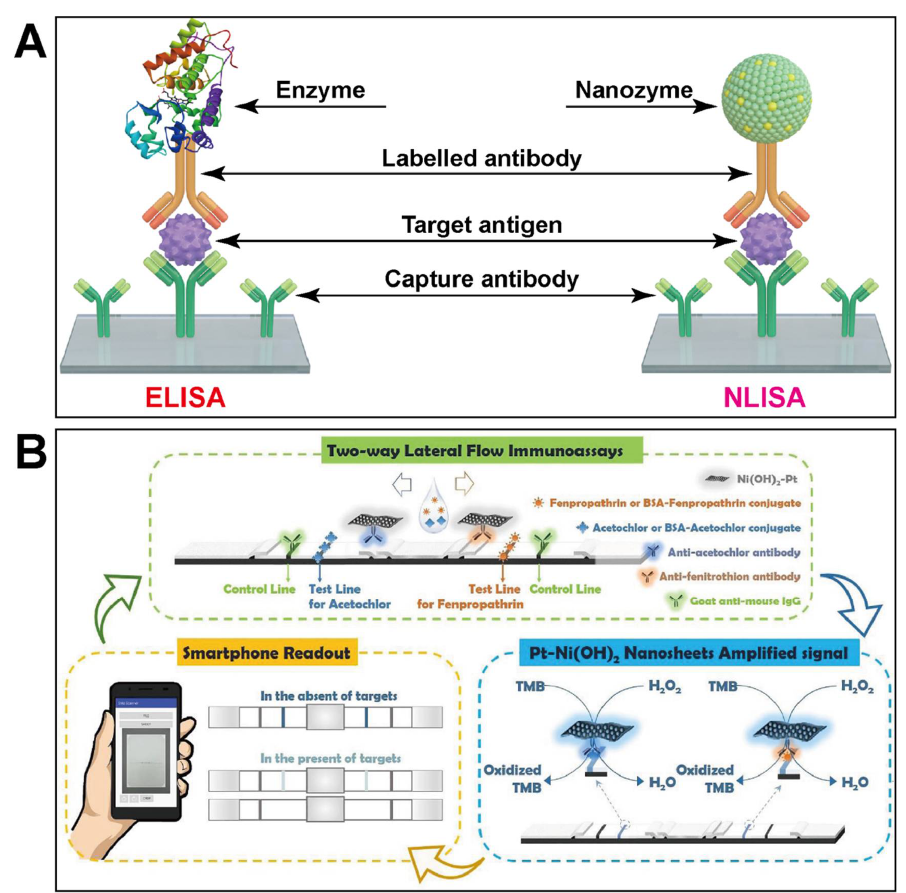
Figure 6. ( A ) compares NLISA and conventional ELISA with a sandwich-like configuration. ( B ) illustrates design of a nanozyme-based two-way lateral flow immunoassay for pesticide biosensing (Reprinted with permission from [111], Copyright 2019,